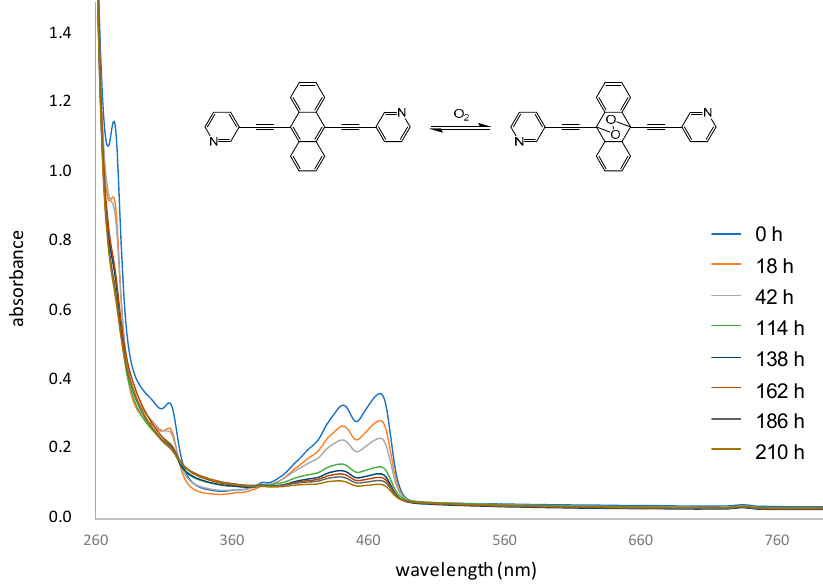
Figure 7. UV–visible spectra of L anthr upon white light irradiation (10 –5 M in DMSO).